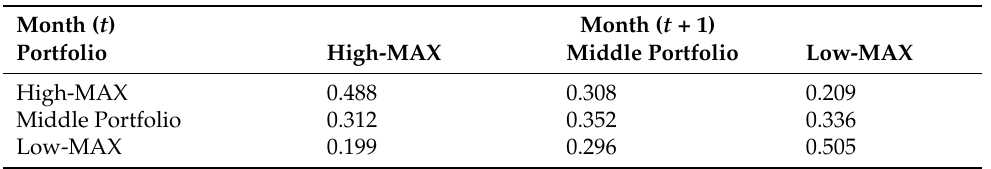
Table 3. This table presents the transition matrix for tercile portfolio analysis. The figures represent the transition probabilities that a stock remains in the same tercile portfolio or switches to another tercile